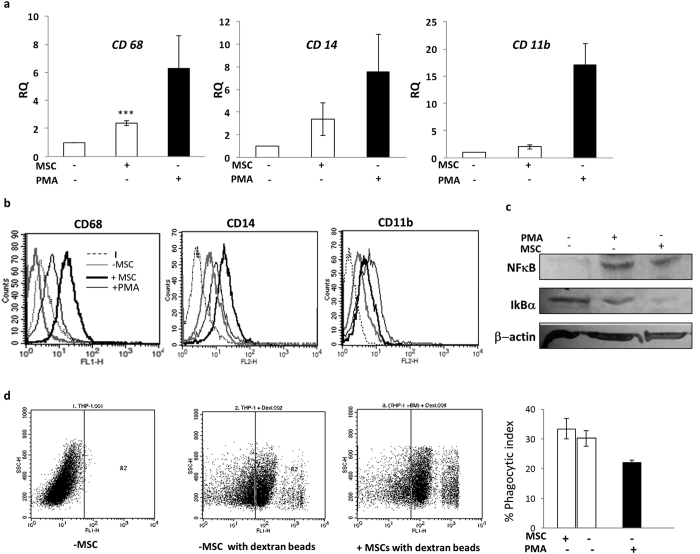
MSCs facilitate monocyte to macrophage differentiation in co-cultures.THP-1 cells were either co-cultured with MSCs (+MSC) or differentiated into macrophages with PMA (denoted as +PMA) for 48 h. MSCs were seeded in upper inserts for MSC-THP-1 co-cultures. After co-culture, cells were washed and analyzed for mRNA expression levels (a), flow-cytometry (b), western blot analysis (c) or phagocytosis assays (d). PMA treated THP-1 was used as differentiated controls for comparison in all the experiments (black filled bars). (a) RQ represents fold increase in human monocyte-macrophage transcripts in comparison to untreated THP-1 cells. (b) Flow-cytometry assessment of cell surface antigens induced upon monocyte to macrophage differentiation. Each histogram represents cell surface expression on THP-1 cells (thick grey line), PMA differentiated THP-1 cells (thin black lines) and THP-1 co-cultured with MSCs (thick black line). Dotted line represents isotype control (I) staining. Histogram overlay is representative of three independent experiments. (c) Representative western blot depicting proteins immune-probed towards the left. β-actin levels was used as loading control. (d) Dot plots represent cells with or without phagocytized dextran-FITC beads. R2 in each dot plot represent cells positive for dextran-FITC uptake. Bar graphs represents % phagocytosis index of THP-1 cells after normalizing with Cytochalasin treated controls (n > 3).